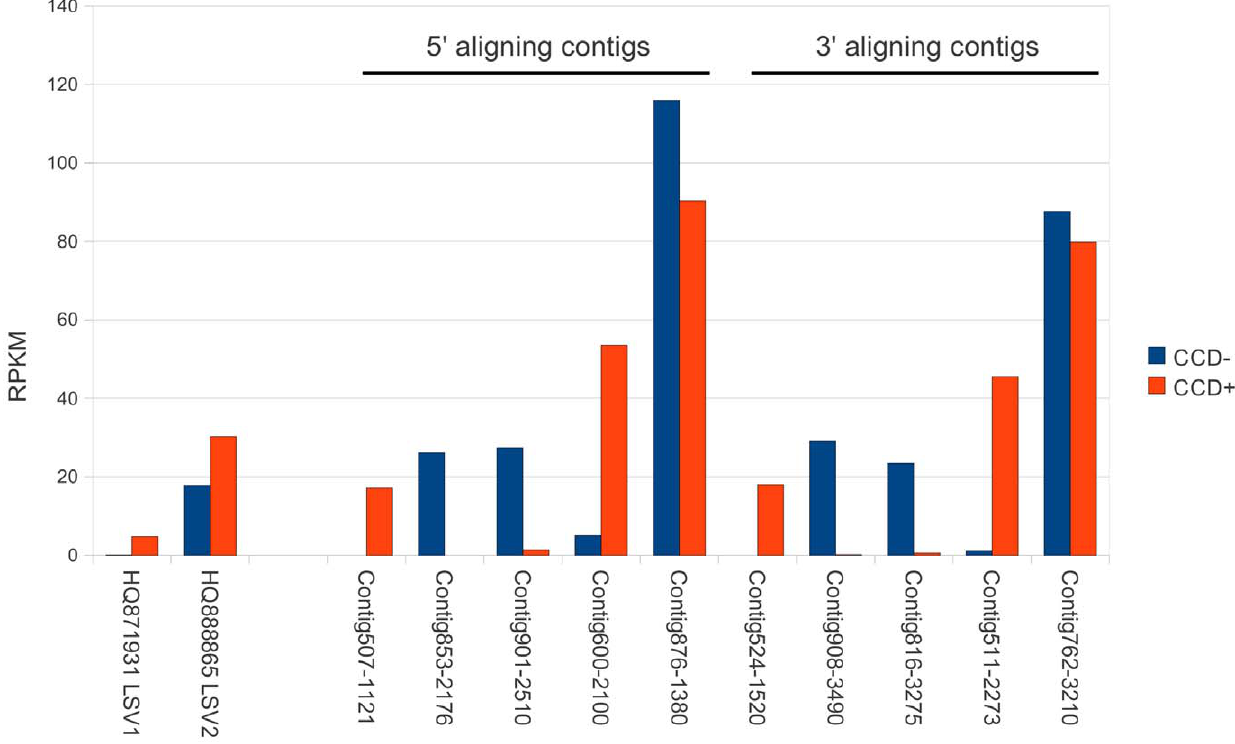
Figure 4. Relative abundance of LSV strains in CCD 2 and CCD + samples. Contigs and accessions are the same as in Figure 3 , with contigs aligning to the 5 9 and 3 9 regions, respectively, of LSV denoted as such. The frequency of mapped reads for each 5 9 aligning contig is mirrored by that of a corresponding 3 9 contig, suggesting physical linkage. Here read counts are normalized by contig length (reads per kilobase per million mapped reads, or RPKM) because the frequency of viral fragments of different lengths are being compared.